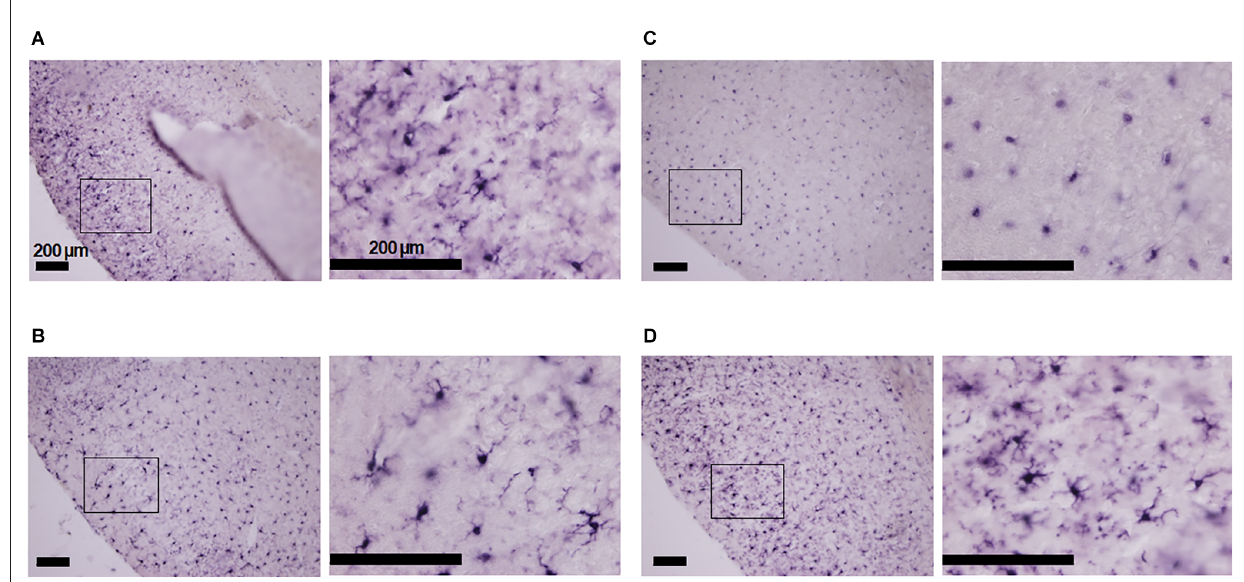
FIGURE1 Morphology of Iba-1 positive cells in the piriform cortex of mice in four conditions: with and without minocycline, without and with hypoxic (7% O 2 ) loading. (A) Room air without minocycline: ramified non-active cells. (B) Room air with minocycline: ramified cells. (C) Hypoxia without minocycline: activated ovoid cells. (D) Hypoxia with minocycline: mostly ramified Iba-1 positive cells intermingled with some ovoid cells. Minocycline suppressed hypoxia-induced microglial activation to some extent in the epileptogenic piriform cortex. The panels’ left-sided rectangles were blown-up in the corresponding right panels. The scale bars are all 200 µ m.